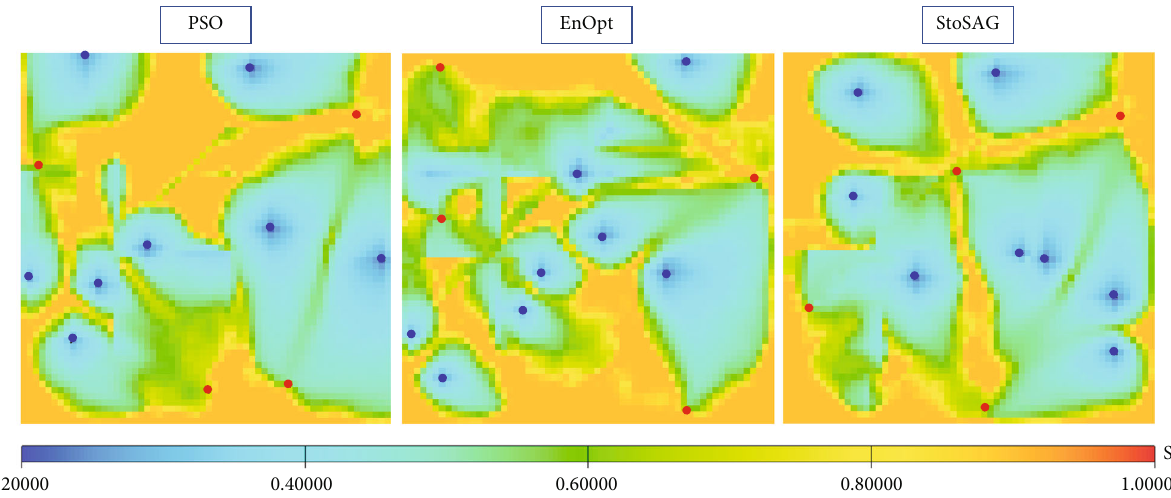
Figure 23: Oil saturation at the fi nal simulation time for di ff erent optimization methods.